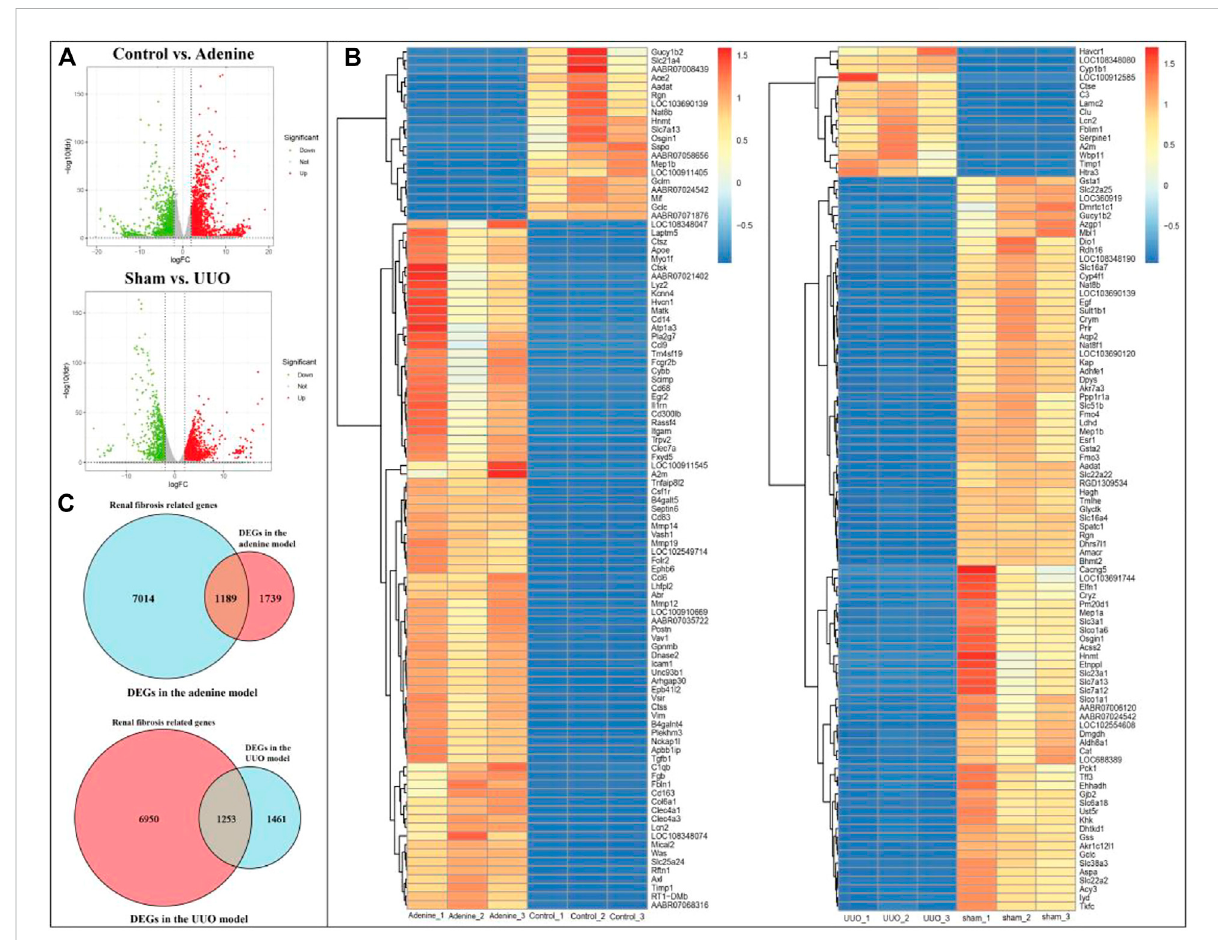
FIGURE 3 DEGs of RF in adenine and UUO models. (A) Volcanic maps showed DEGs in the adenine and UUO models, respectively. Red represented high expressed genes, green represented low expressed genes, and gray represented no different genes. (B) Heatmaps showed the top 100 DEGs with FDR value < 0.05 in the adenine and UUO models, respectively. Red areas represented highly expressed genes and blue areas represented lowly expressed genes. (C) Venn diagram showed the intersection genes between RF-related genes and DEGs in the adenine and UUO